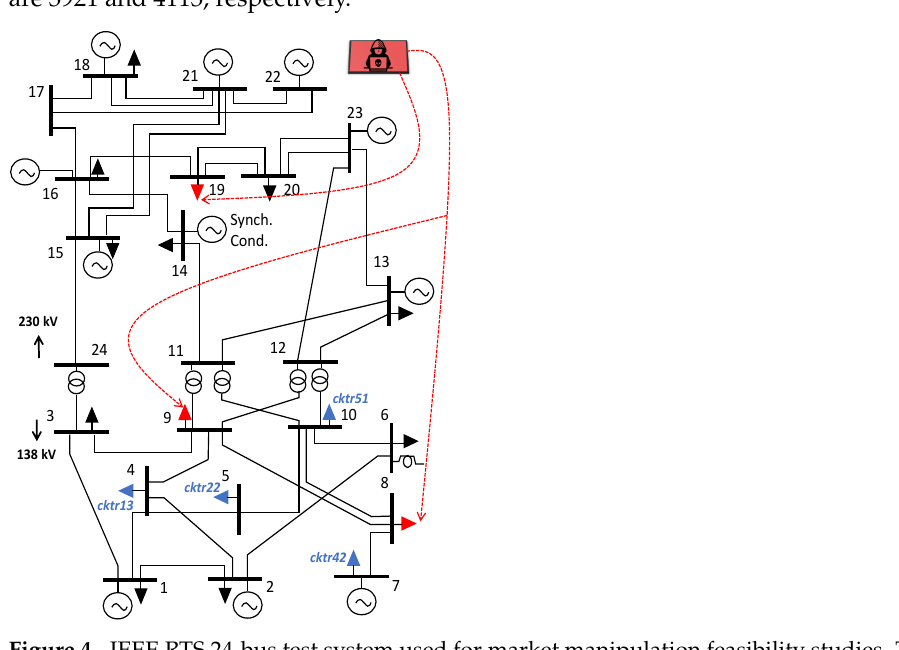
Figure 4. IEEE RTS 24-bus test system used for market manipulation feasibility studies. The ‘blue’ loads represent the loads that are replaced with the multi-conductor models for the cktr13, cktr22, cktr42, and cktr51 distribution systems. The ‘red’ loads represent the loads (distribution systems) that are targeted by